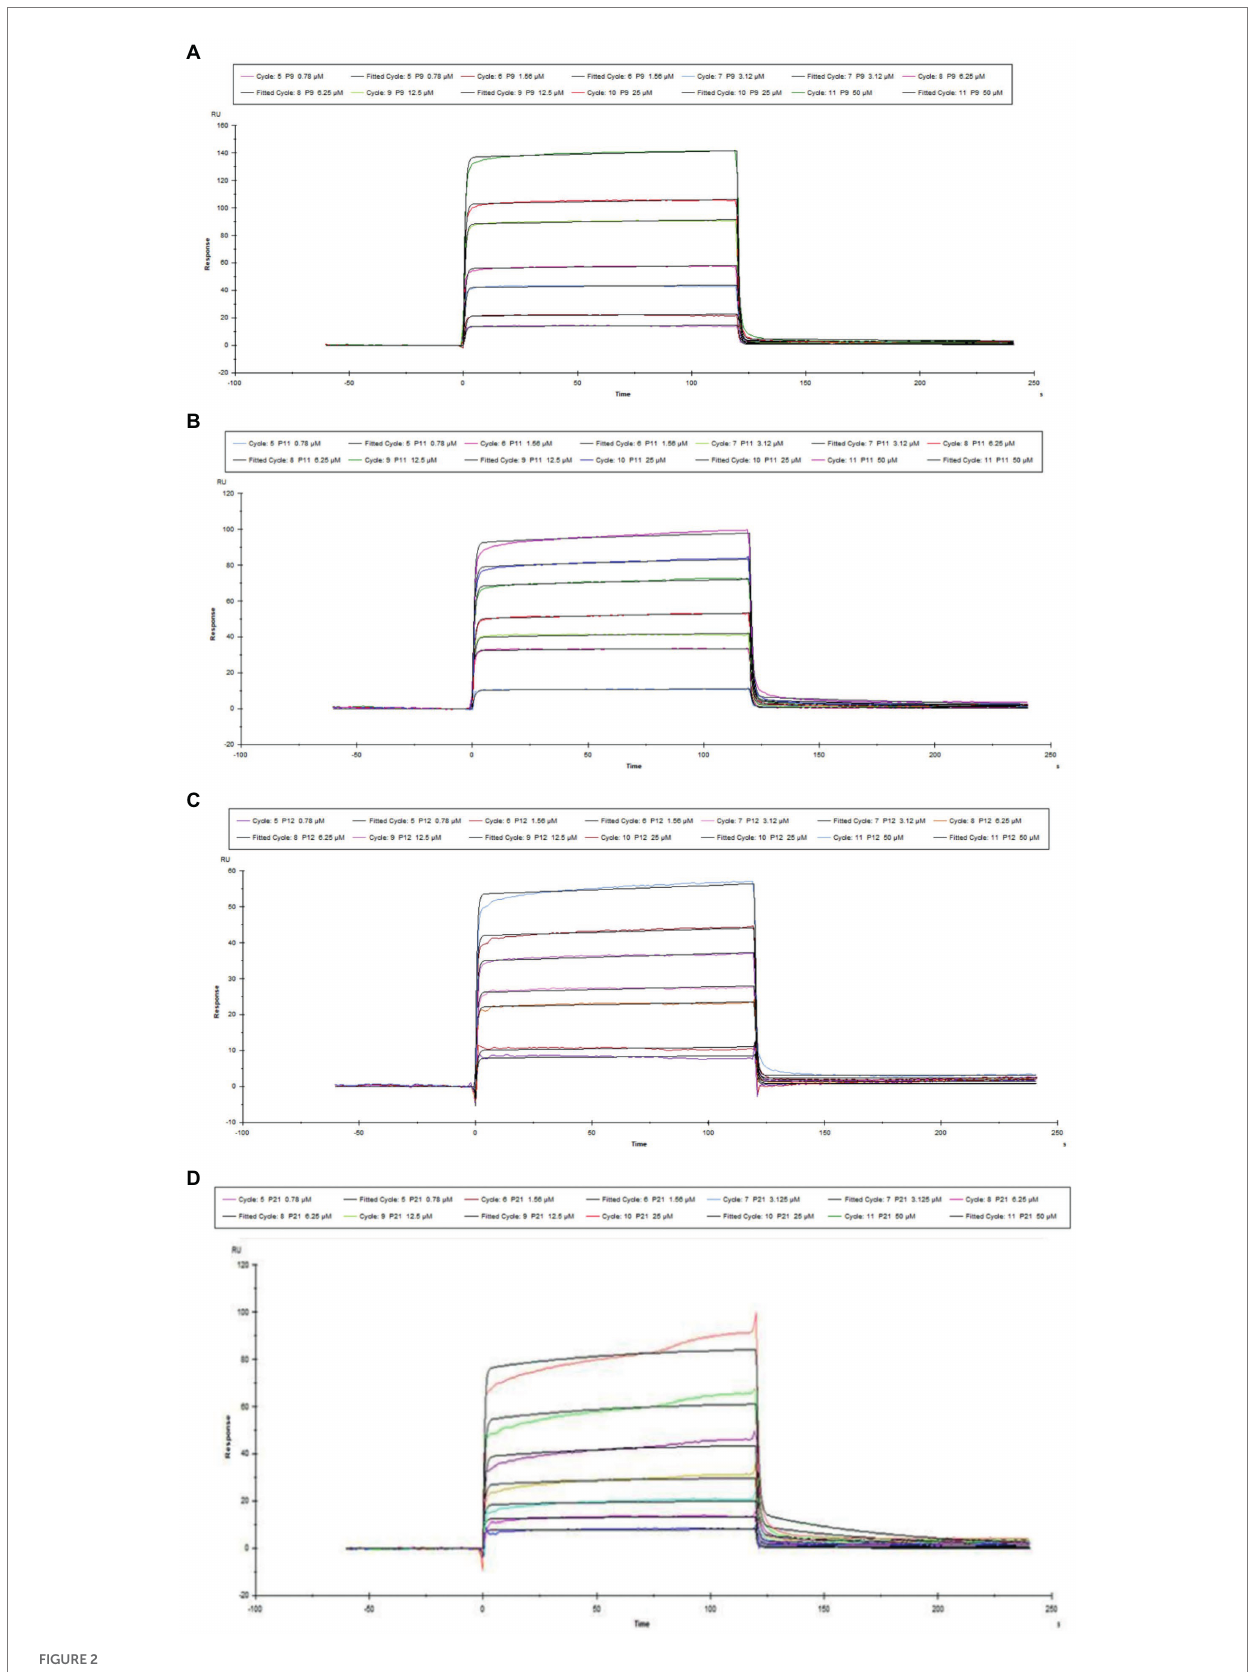
FIGURE 2 Kinetic curve diagram of the interaction between polypeptide and A β 1–42 . (A) P9 (B) P11 (C) P12 (D)